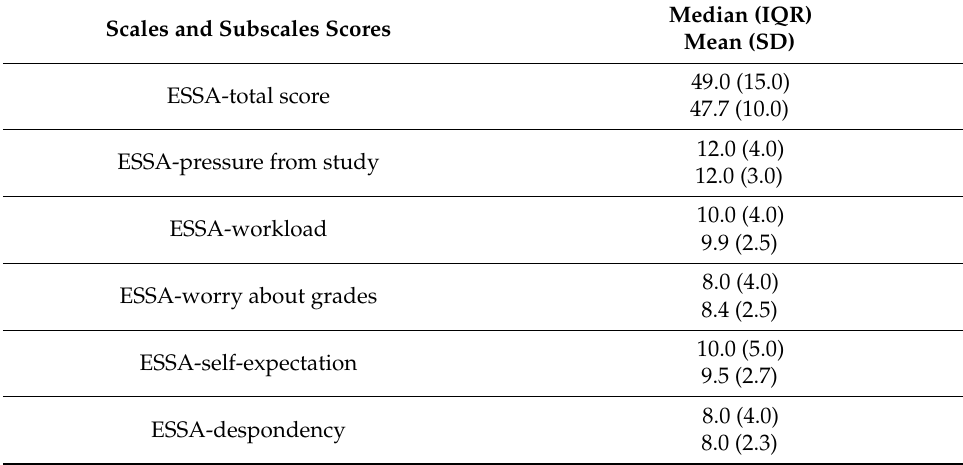
Table 2. Samples’ study’s measurements (N = 399).